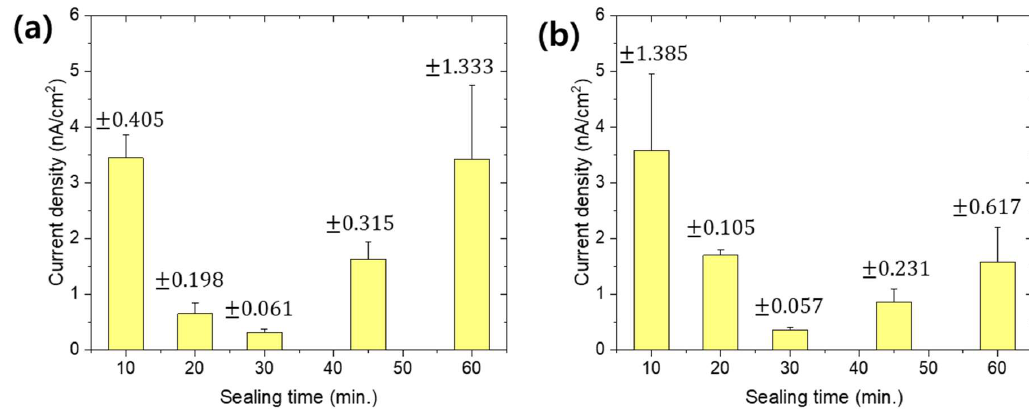
Figure 3. Potentiodynamic polarization curves of anodized aluminum alloy 6061 with ( a ) nickel acetate hot sealing (NAHS) and ( b ) nickel fluoride cold sealing (NFCS).